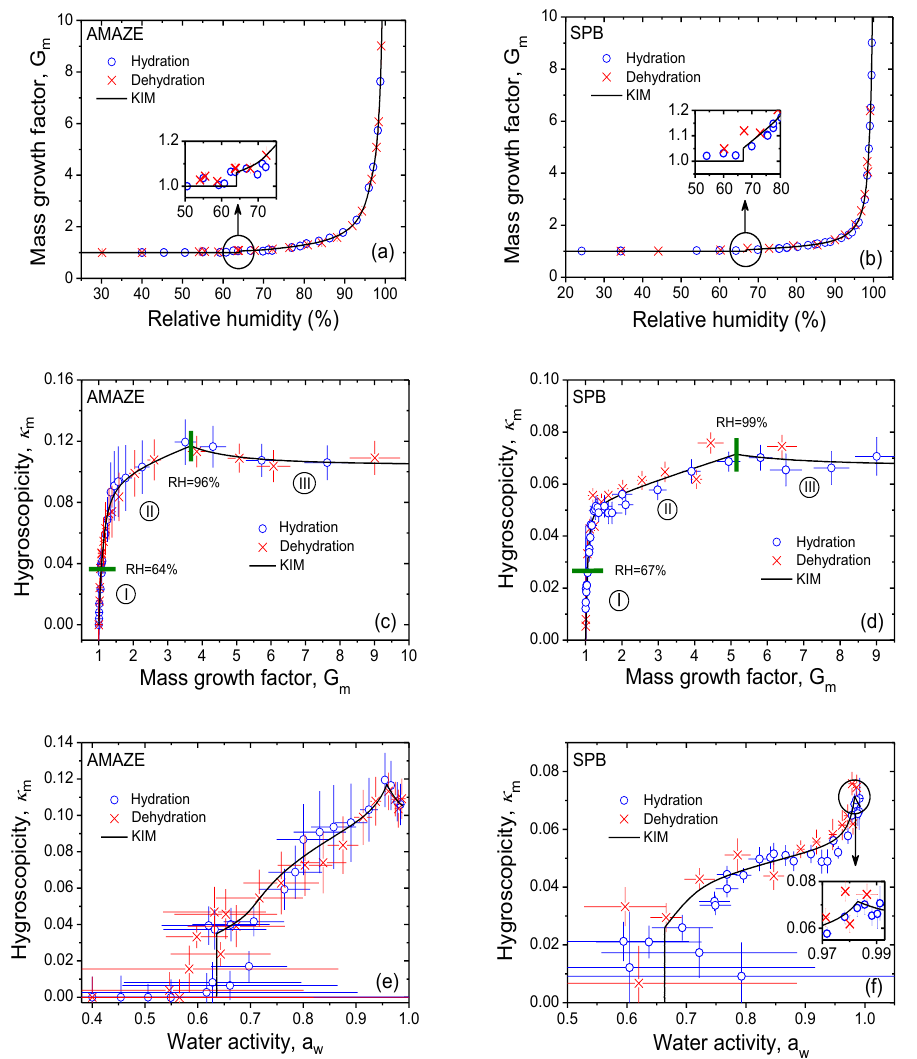
Figure 6: Hygroscopic properties of atmospheric aerosol samples from tropical rainforest air (AMAZE) and boreal rural air (SPB, Table 2): (a, b) mass growth factors ( G m ) observed as a function of relative humidity compared to KIM; (c, d) mass-based hygroscopicity parameters ( κ m ) calculated as a function of mass growth factor (Appendix C, Eq. C2); and (e, f) mass based hygroscopicity parameters ( κ m ) plotted against water activity. The data points and error bars (mean value ± standard deviation) are from FDHA experiments of hydration (blue circles) and dehydration (red crosses). The black lines are fits of KIM Eqs. (36)–(38). The labels I, II, and III indicate different regimes of hygroscopicity; the borders of the corresponding fit intervals are indicated by green bars (c, d) .